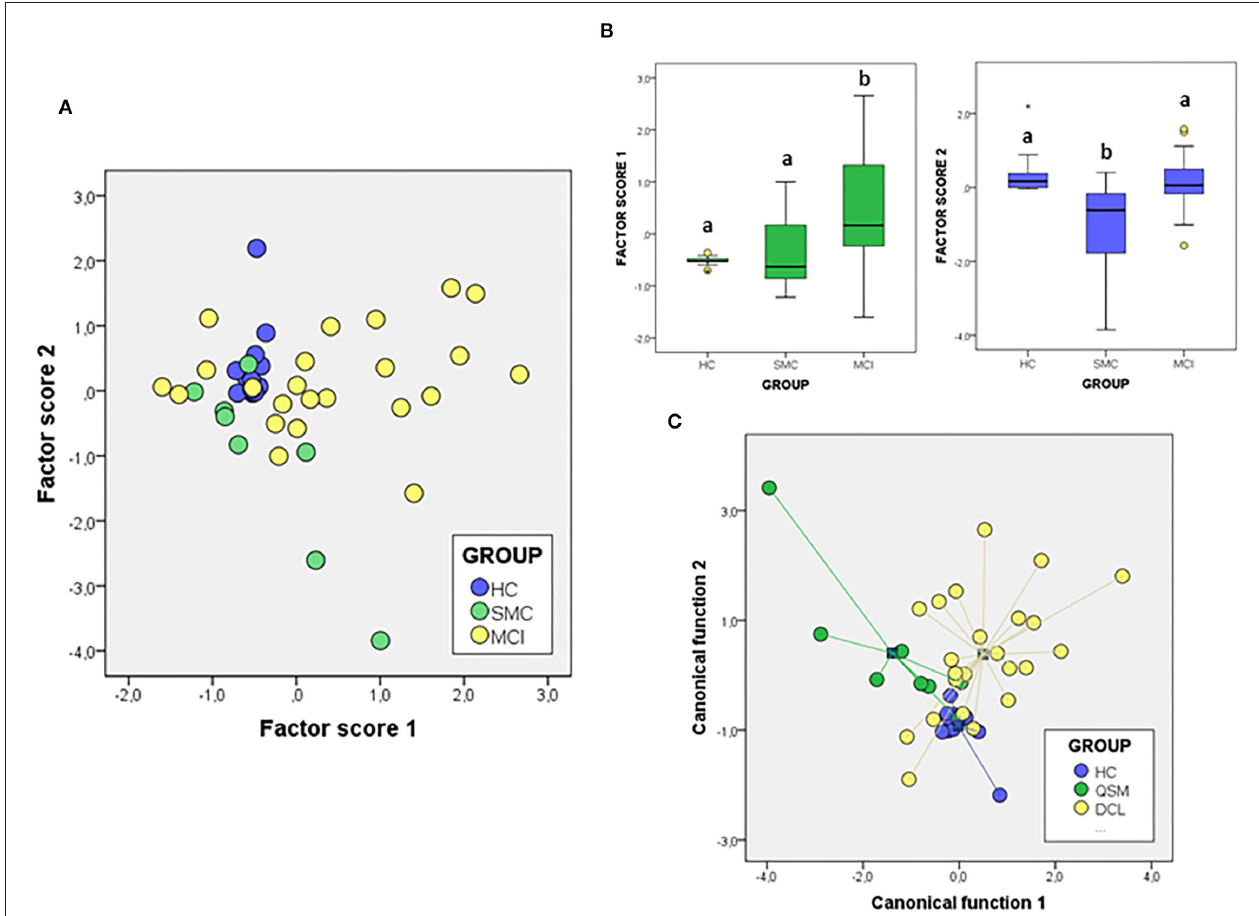
FIGURE 5 | The PCA (A,B) and DFA (C) of signalosome proteins in the CSF of subjects from HC, SMC, and MCI groups. The factor scores in plot (B) were submitted to one-way ANOVA followed by post-hoc Tukey’s HSD test. The different letters indicate statistically significant differences with p <